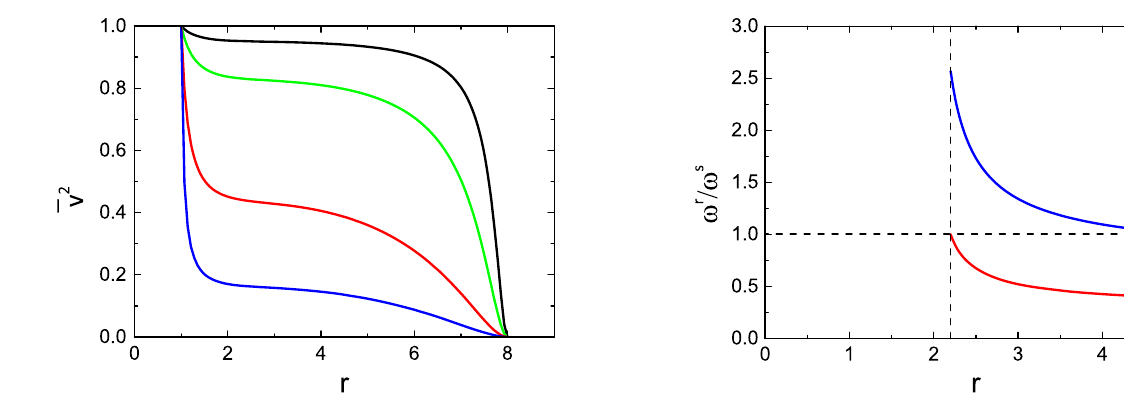
Fig. 6 Frequency shift outside the horizon of a Schwarzschild BH: signals exchanged between A and B , A – B (gravitational redshift) and B – A (gravitational blueshift), r A = 2 . 2, r B = 5; ( M =